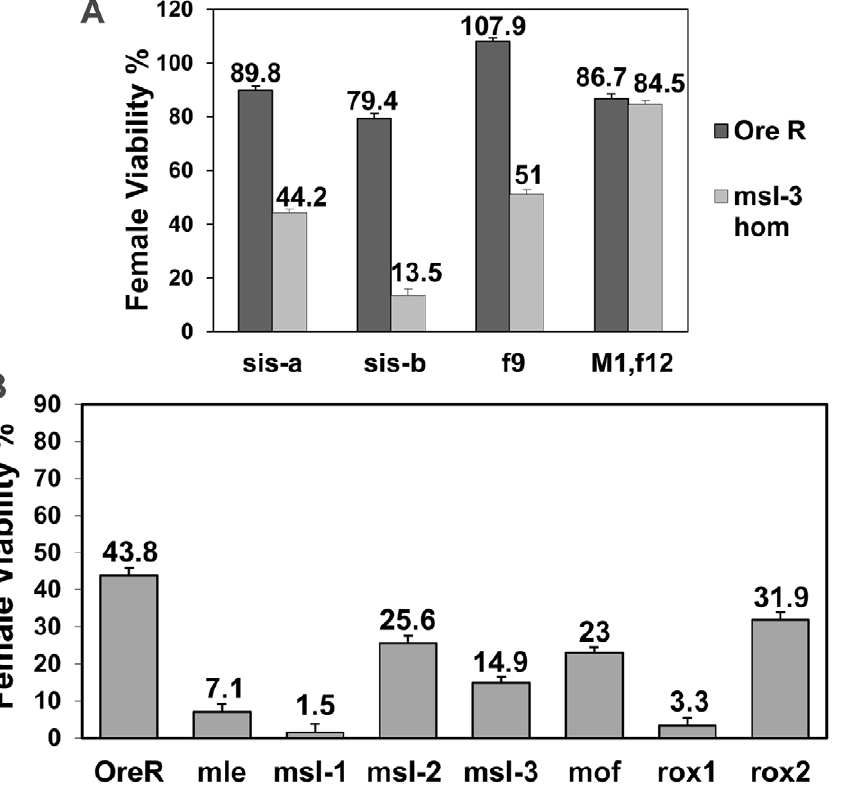
Figure 2. msls act early in the female sex determination process, and all key components of the dosage compensation complex, affect female viability. (A) msl-3 1 homozygous mothers mated to males mutant for single numerator gene ( sis-a 1 or sis-b sc3-1 ) or Sxl early phase (f9) or late phase defective (M1, f12) allele (test class total n=1135, 1047, 879, 404, 1129, 696, 915, 924, respectively). sis-b sc3-1 cross was done at 29 u C, the non-permissive temperature for this temperature-sensitive allele. Percent viability of females relative to their brothers is shown with percentage standard error. Relevant genotype of fathers shown on x-axis. (B) w, sis-b sc3-1 , sis-a 1 , m /FM7 females were mated to either Ore R, mle 1 /CyO, msl-1 L60 / CyO, msl-2 1 /CyO, msl-3 1 /TM3, mof 2 /Y; 18H1[mof + ]/ + , roX1 ex6 /Y or roX2 2 /Y males (test class total n=420, 241, 208, 285, 363, 447, 408, 418, respectively). Percent viability of sis-a, b / + females with the msl mutation relative to their FM7/ + sisters also carrying the msl mutation is shown, with percentage standard error. For mof it is for females that did not receive the 18H1[mof + ] transgene. Relevant msl genotype of fathers shown on x